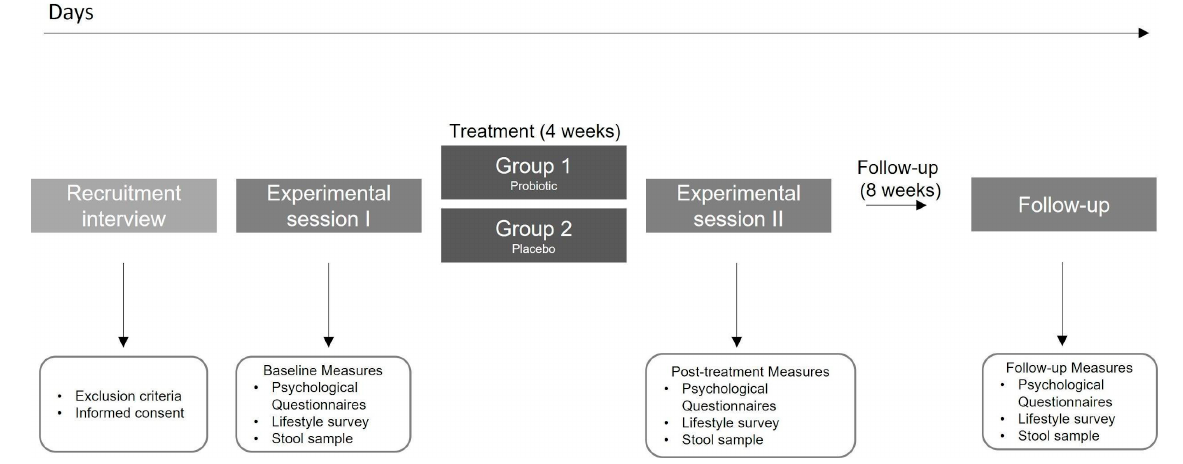
Figure 1. Study protocol.